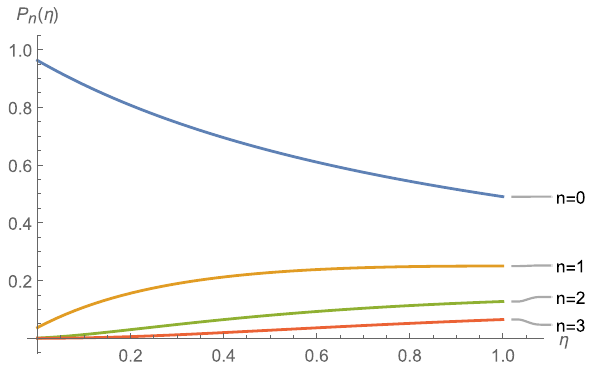
Figure 1. The probability P n (η) (see Eq. (30)) for n = 0, 1, 2, 3 is depicted for the values k 0 = 0.02 ω 0 , χ 0 = 0.1 ω 0 , and ν = 0.99 ω 0 in terms of the dimensionless variable η in large-time limit.